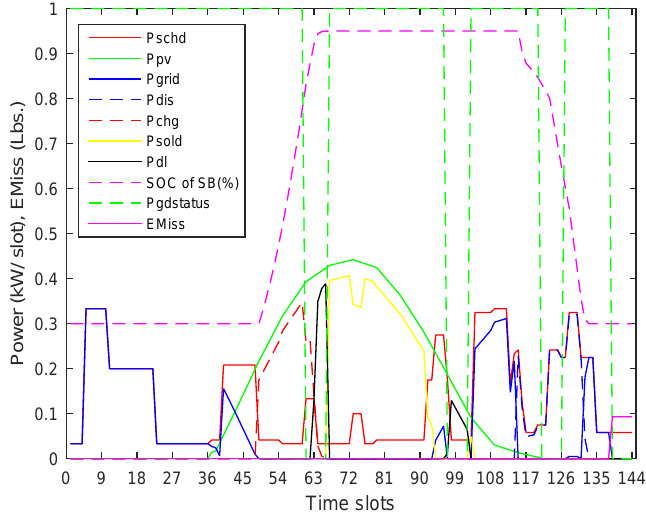
Figure 13. Power and emission profiles for DRSREODLDG-based HEMS operation for solution-27.